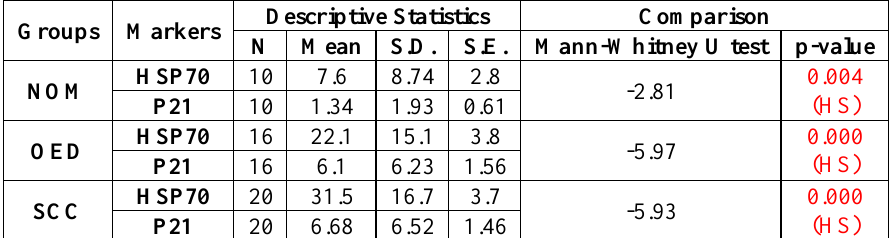
Table 2: Descriptive statistics and groups’ comparison in each marker